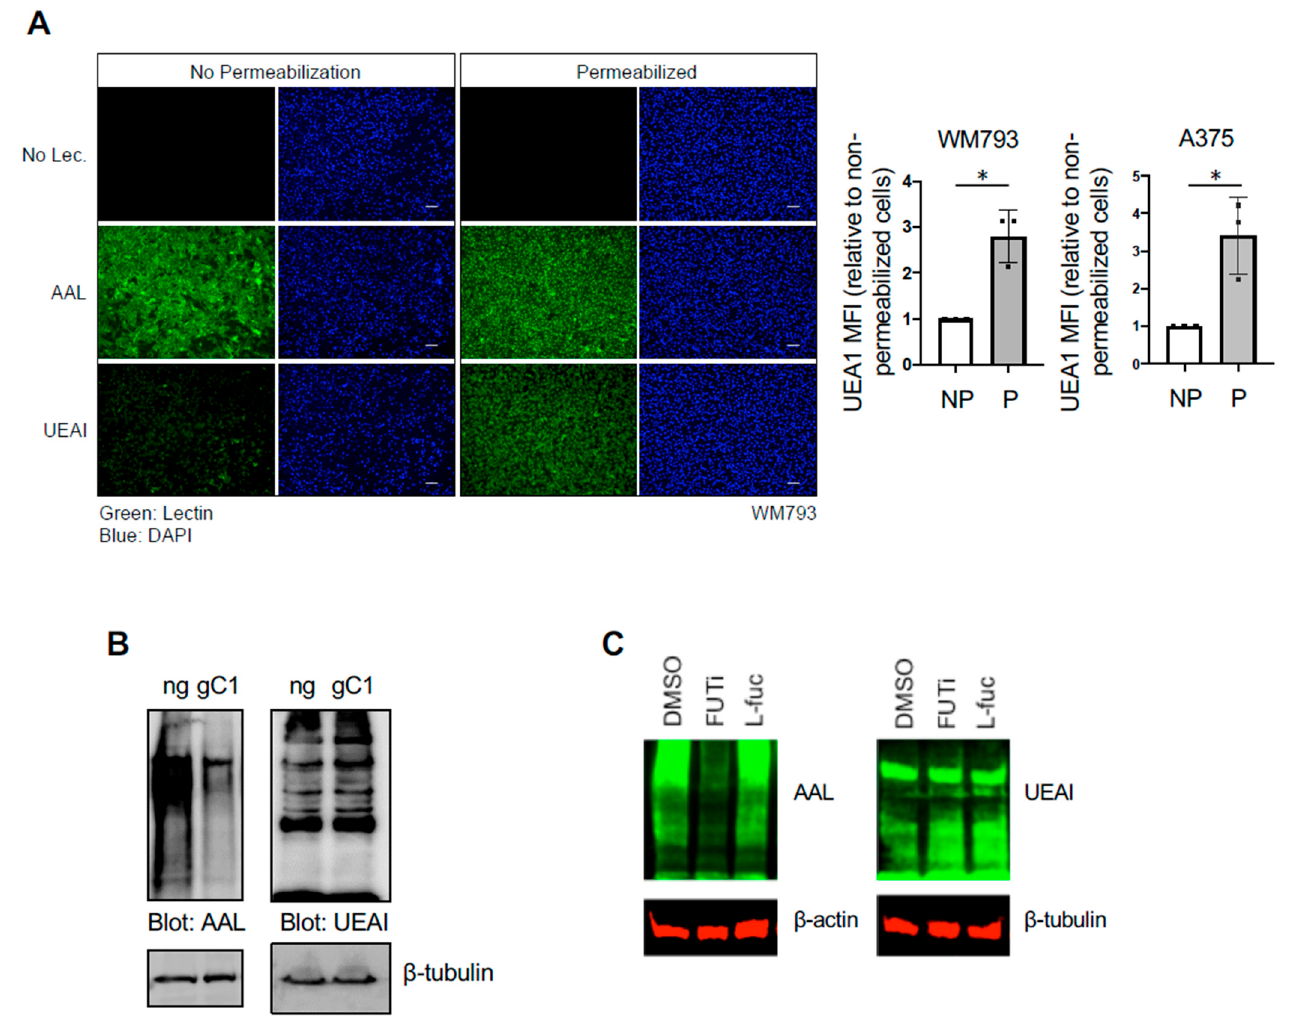
Figure 1. UEAI recognizes intracellular proteins. ( A ) WM793 cells were fixed and permeabilized with Triton X-100 or left unpermeabilized. Cells were subsequently stained with DAPI nuclear stain, FITC-AAL, FITC-UEAI, or no lectin as a control. Cell were visualized by IF for qualitative lectin staining (left panel). For quantification, WM793 and A375 cells were stained as above and analyzed by flow cytometry (right panel; MFI: Mean Fluorescence Intensity (of UEA1 per cell)). * p = 0.006 ( B ) Cells transduced and selected with lentivirus containing Cas9/no guide (ng) or Cas9/sgSLC35C1 (gC1) were grown in normal growth media and harvested for protein lysate. Lysates were probed with AAL and UEAI lectin to determine global levels of Golgi-dependent fucosylation. ( C ) WM793 cells were cultured for three days in 2-fluorofucose (2-FF, FUTi, 250 µM), L-fucose (L-fuc, 250 µM), or control. Cells were harvested for protein lysate and blotted for global AAL and UEAI levels.